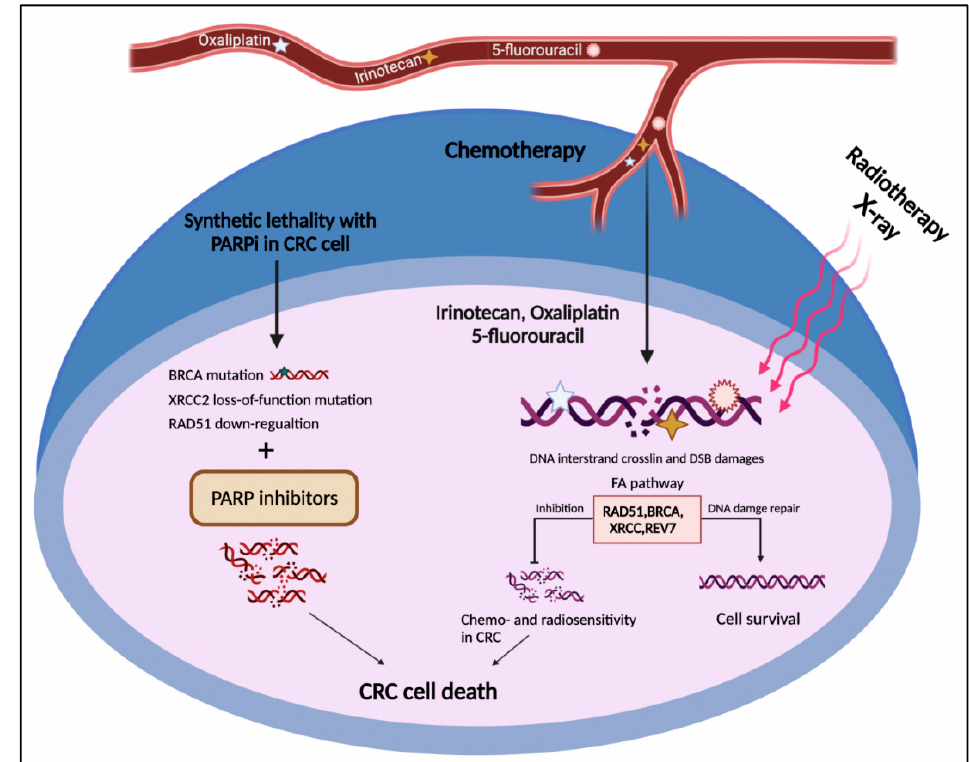
Figure 4. The FA pathway involvement in CRC treatment. The DNA damages caused by radio- and chemotherapy in CRC cells result in cell death. On the other side, up-regulation of the FA pathway components such as RAD51, BRCA1/2, XRCC2, and REV7 leads to HR restoration and drug resistance. The deficiency in the FA pathway components such as BRCA1/2, XRCC2, and RAD51 represents the synthetic lethal relationship with PARP1, which might introduce druggable candidates for PARP inhibitors in CRC cells.